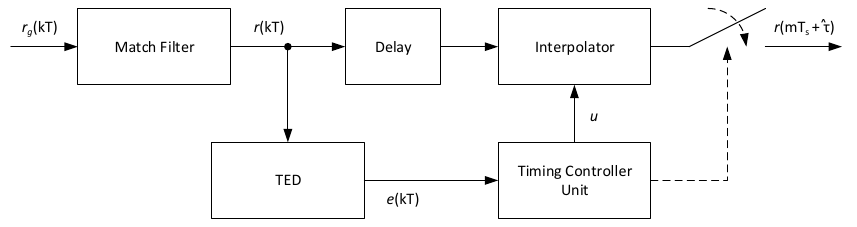
Figure 2. Feedforward timing